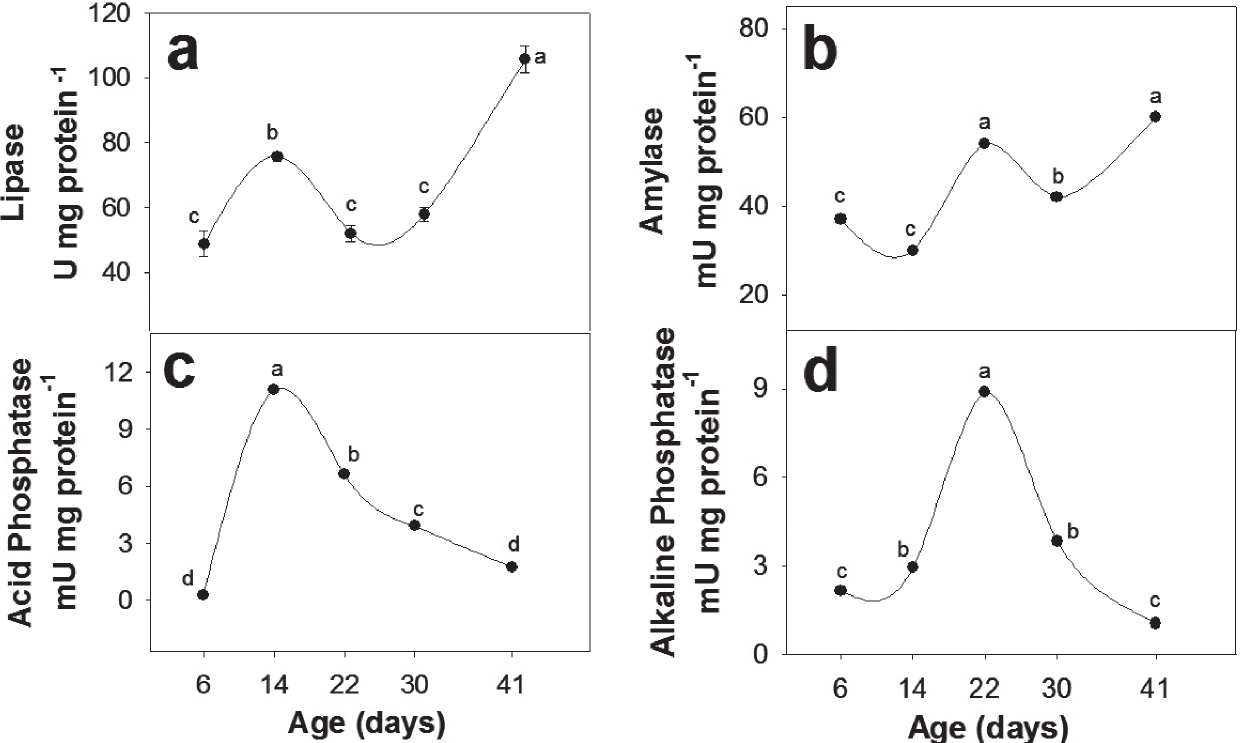
Fig. 3. Digestive enzymatic activity during ontogeny of Parachromis dovii larvae (means ± SD, n= 3 replicates). (a) specific lipase activity, (b) specific α-amylase activity, (c) specific acid phosphatase activity, (d) specific alkaline phosphatase